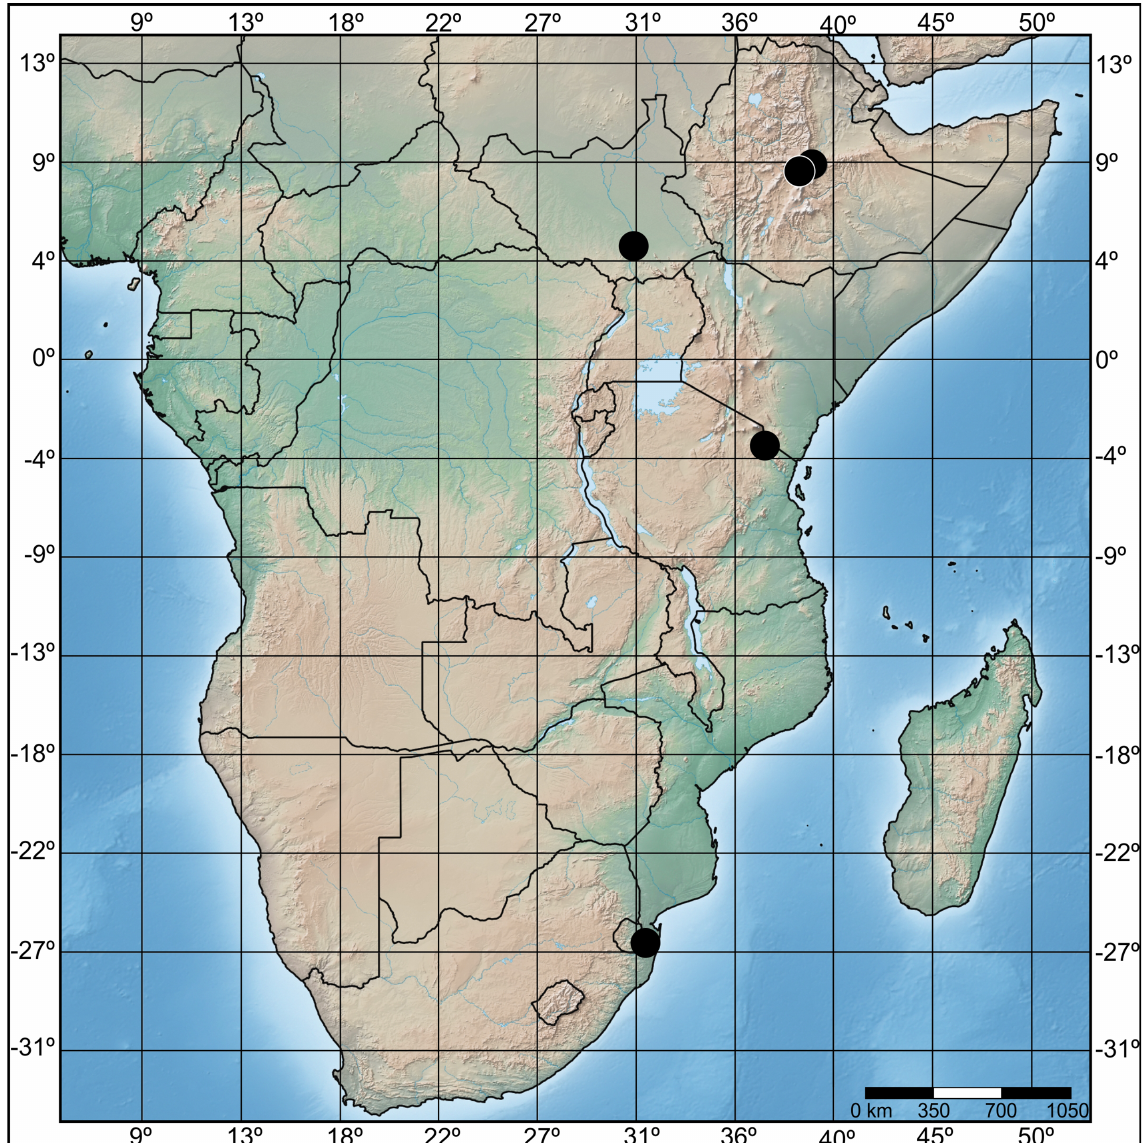
Fig. 515. Collecting localities of Evarcha werneri (Simon, 1906) comb.